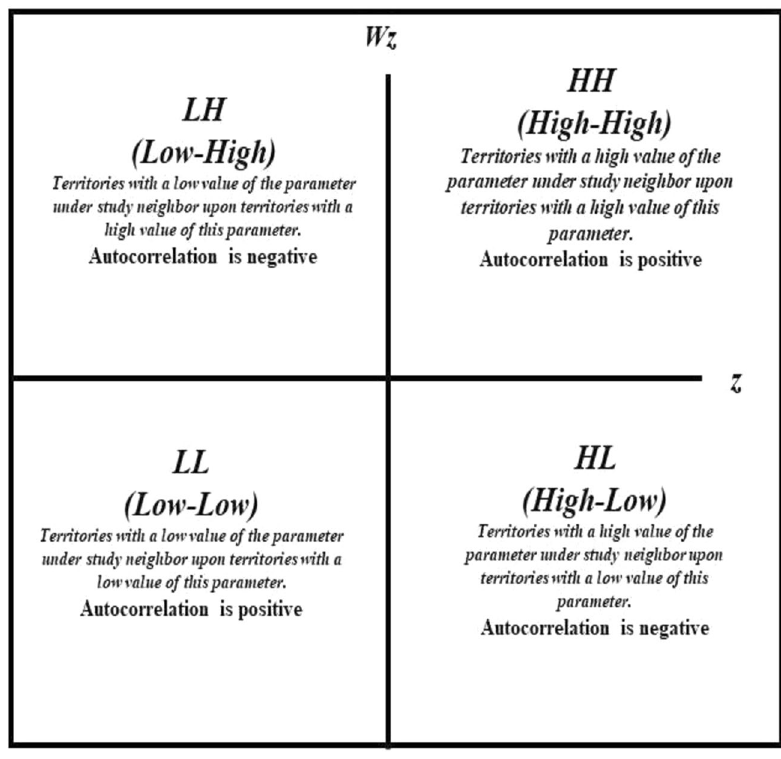
Fig. 2 Spatial scatter diagram of the Moran’s index. LH square: cities located in this square have relatively low values of the parameter being analyzed and are surrounded by cities with relatively high values of the parameter being analyzed. HH square: extreme cities have relatively high values of the parameter being analyzed and is adjacent to the cities which also have relatively high values of the parameter being analyzed. LL square: cities located in this square have relatively low values of the parameter being analyzed and are surrounded by cities which also have relatively low values of the parameter being analyzed. HL square: cities located in this square have relatively high values of the parameter being analyzed and are surrounded by territories with relatively low values of the parameter being